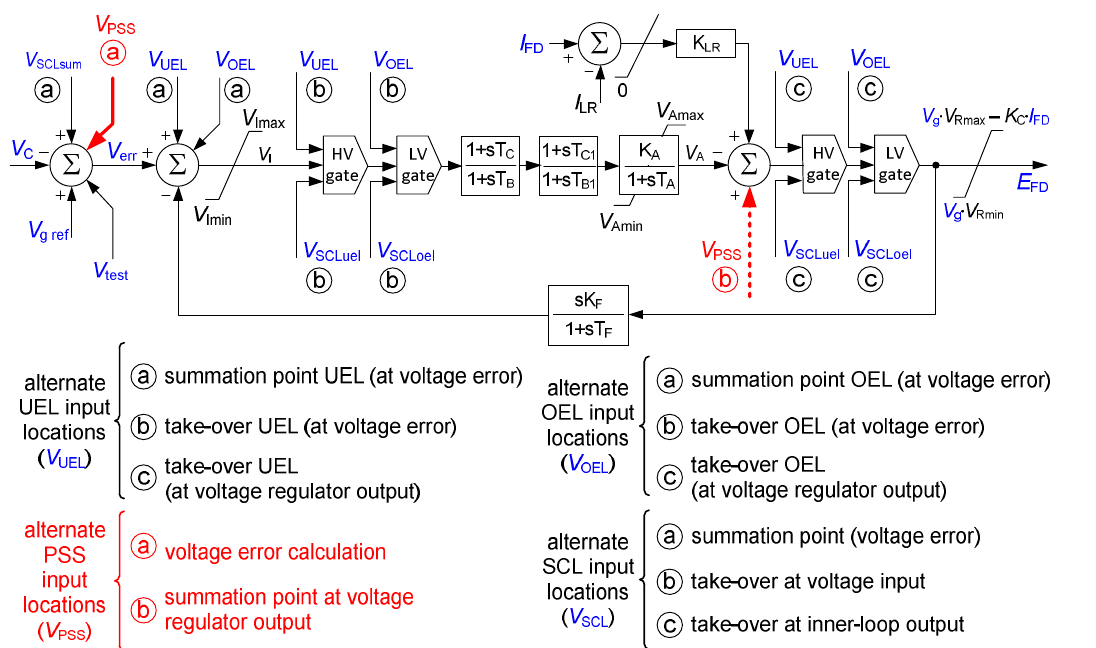
Figure 2. ST1C-type excitation system model [18].